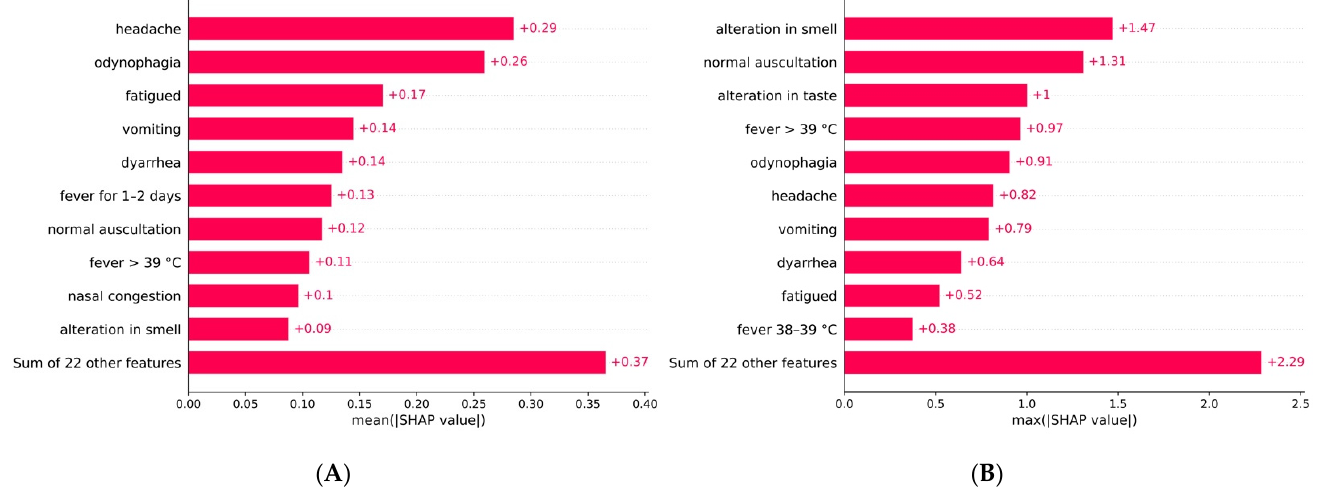
Figure 3. ( A ) Absolute mean impact and ( B ) absolute maximum impact of each variable for the general model.